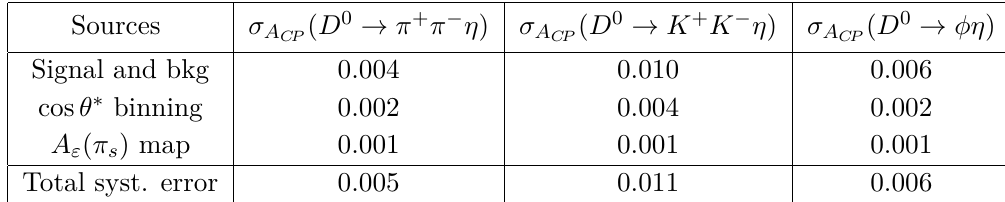
Table 3 . The absolute systematic uncertainties for A CP measurement in each SCS decay